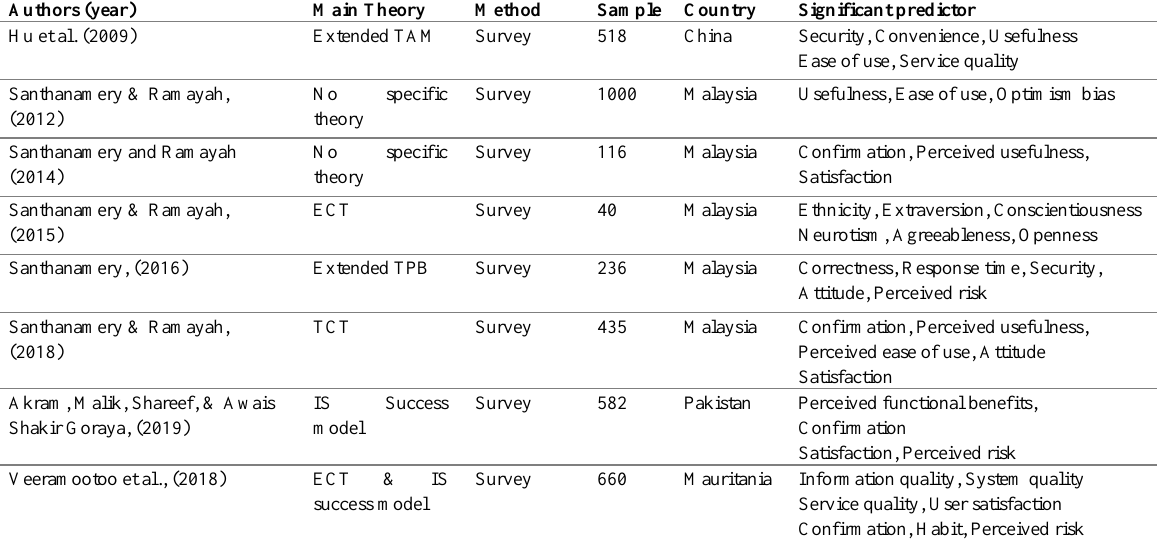
Table 1: Literature review